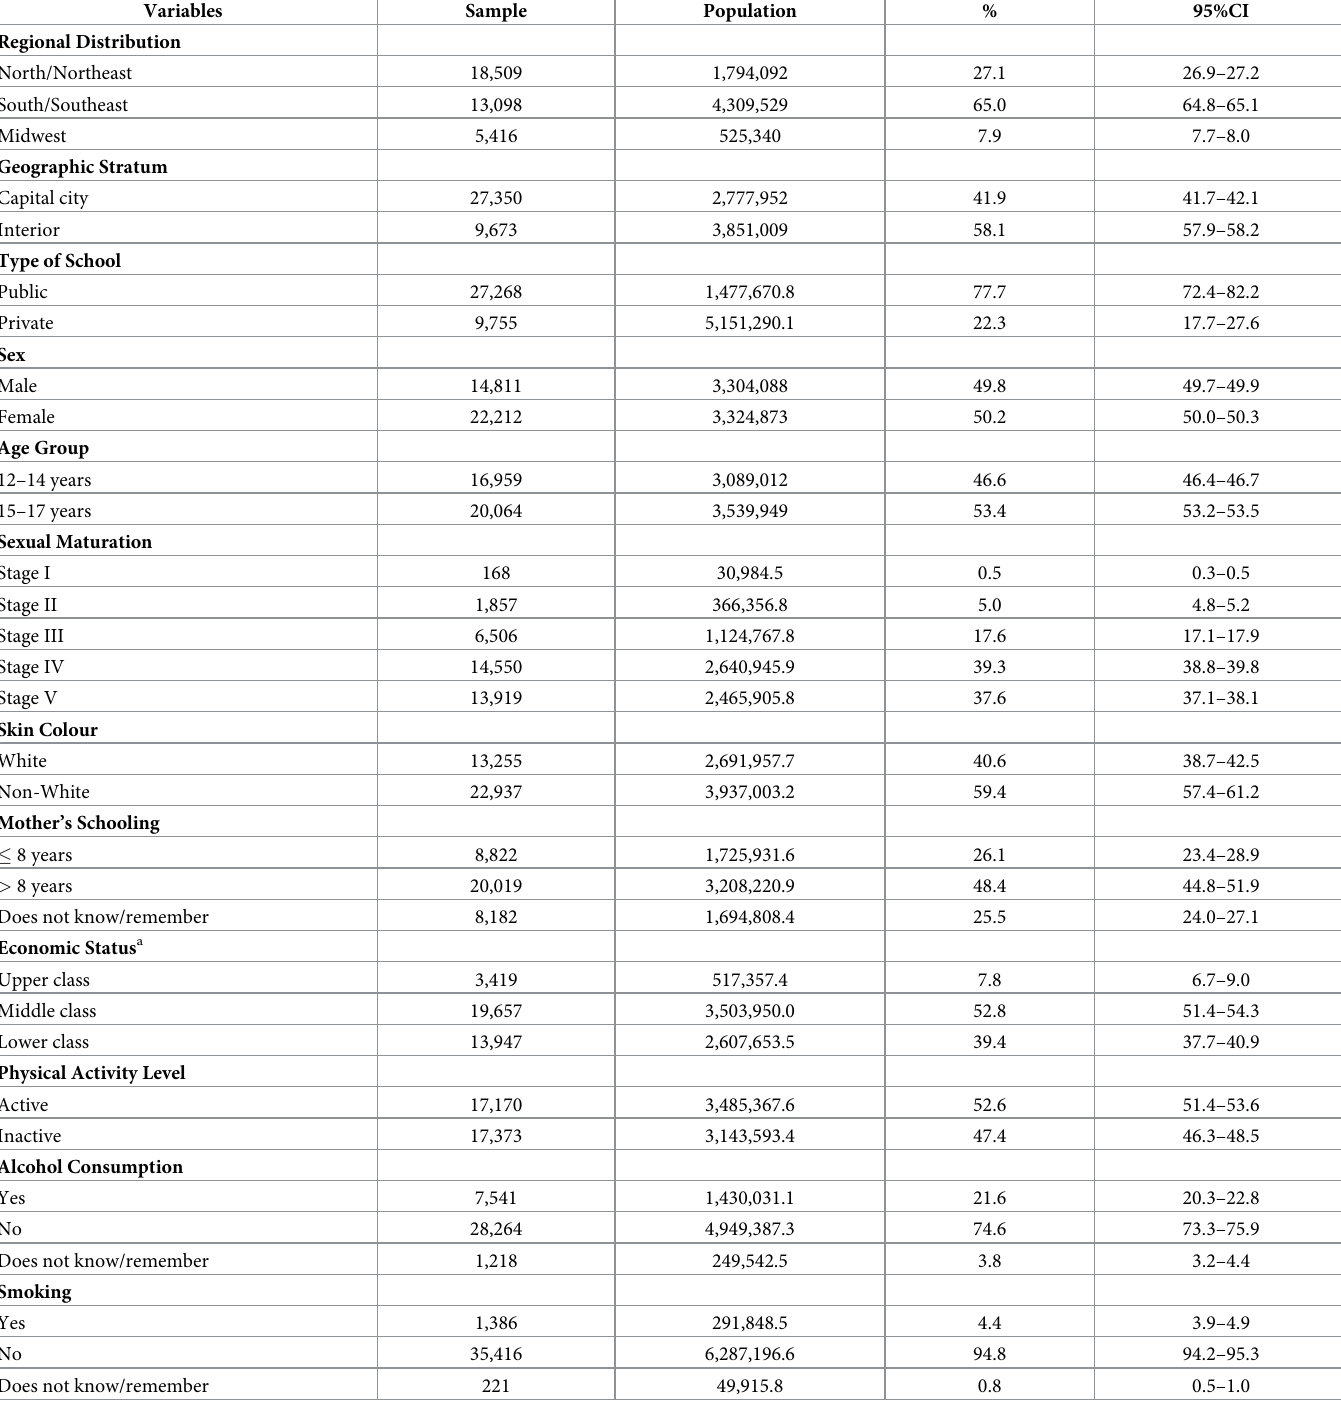
Table 2. General characterisation of Brazilian adolescent students. ERICA Study,